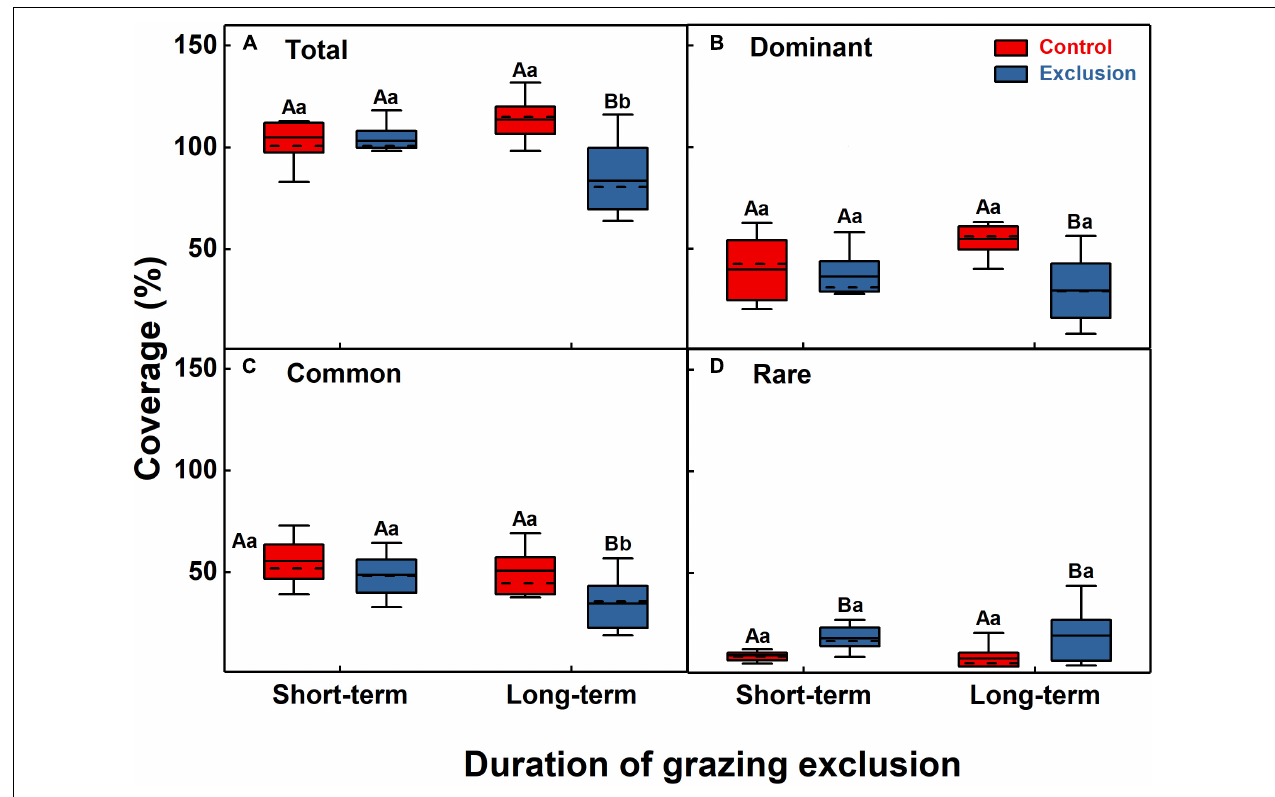
FIGURE 1 | Grassland coverage of the community (A) and dominant (B) , common (C) , and rare (D) species under short-term and long-term grazing exclusion and in control stands. Boxes in box plots extend from the first (25%) to third (75%) quartiles, with solid and dashed lines at the mean and the median value, respectively. Whiskers extend from the 2.5th to the 97.5th percentile ( n = 10). Uppercase letters indicate the differences between control and grazing exclusion under the same duration, while lowercase letters represent the differences between the short-term and long-term application of the same treatment (control or grazing exclusion).